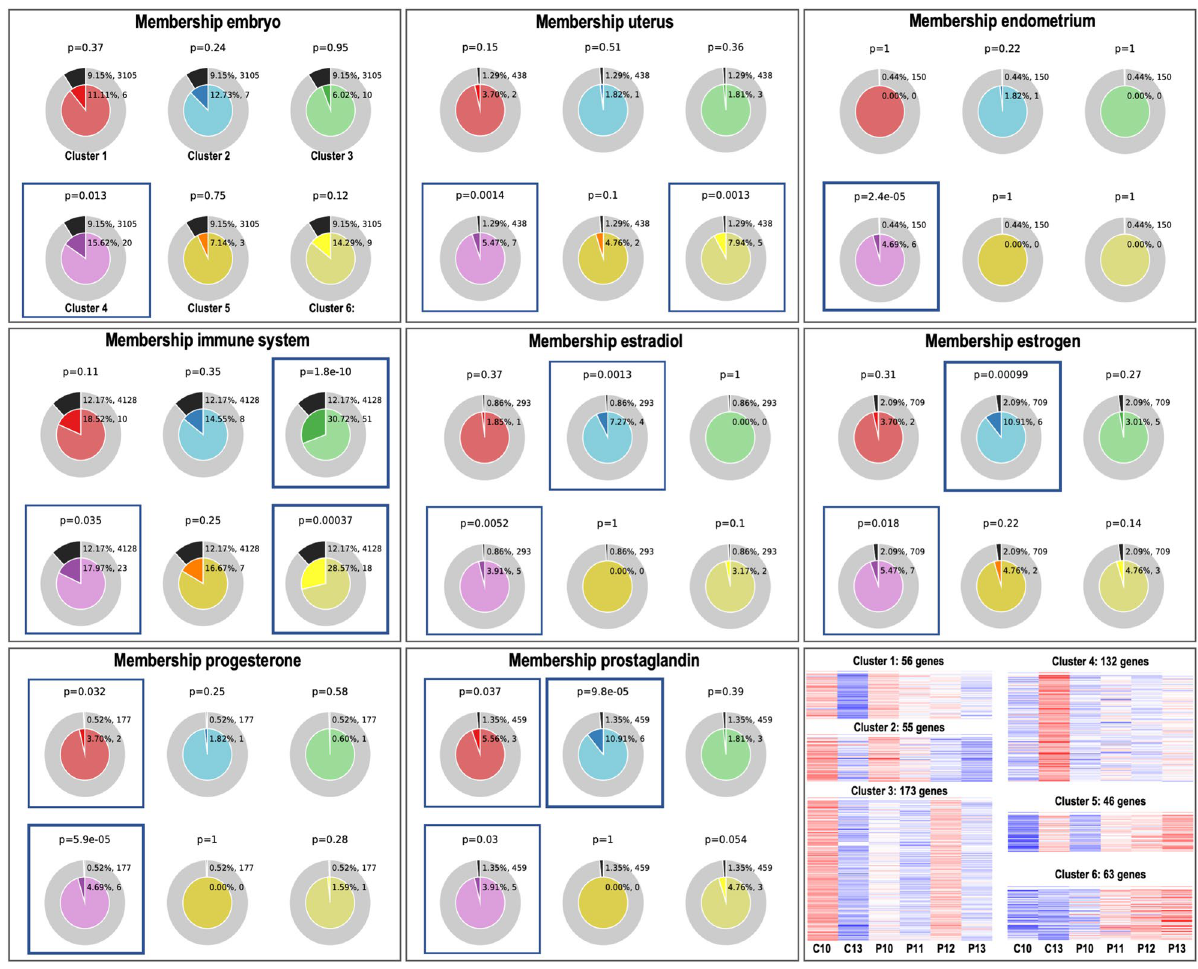
Figure 5. Metascape membership analysis for differentially abundant mRNAs in uEVs of the 6 clusters of similar expression profiles. Gene lists of the 6 SOTA clusters were uploaded to Metascape and membership analysis was performed for selected keywords. The outer ring of each pie (grey) represents the number and percentage of genes in the background that are associated with the membership term. The inner ring of each pie shows the number and percentage of genes in the individual input gene list that are associated with the membership term. The P-value ( P ) at the top of each pie indicates whether the membership term is significantly enriched. SOTA clusters illustrated in Fig. 4 are shown again at the bottom right. Images created with Metascape webtool (https:// metas cape. org) 32 and modified with Adobe Photoshop